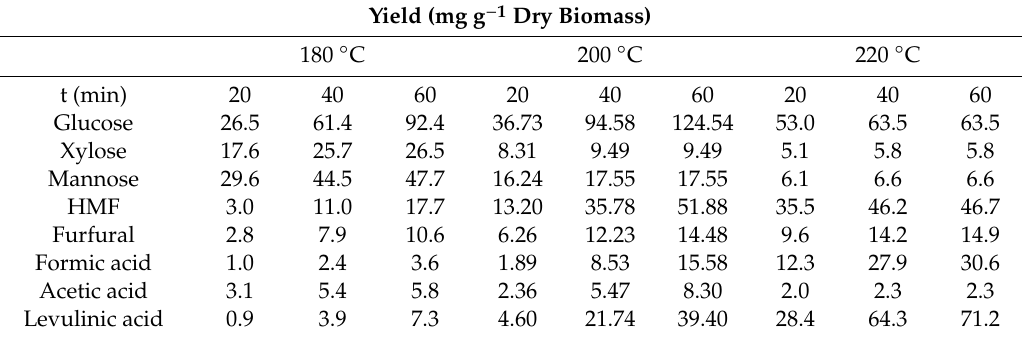
Table 2. Main components yield after spruce wood hydrolysis with 0.05 mol L − 1 sulphuric acid at di ff erent temperatures. HMF, hydroxymehtylfurfural.